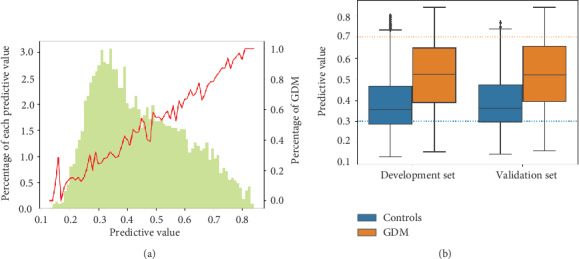
Predictive values for participants with and without GDM in the cohorts. (a) Distribution of predictive value and its relationship with the observed GDM in the combined cohort (development and validation cohort). (b) Distribution of predictive values in the development and validation cohort. Data are presented as median and interquartile ranges.